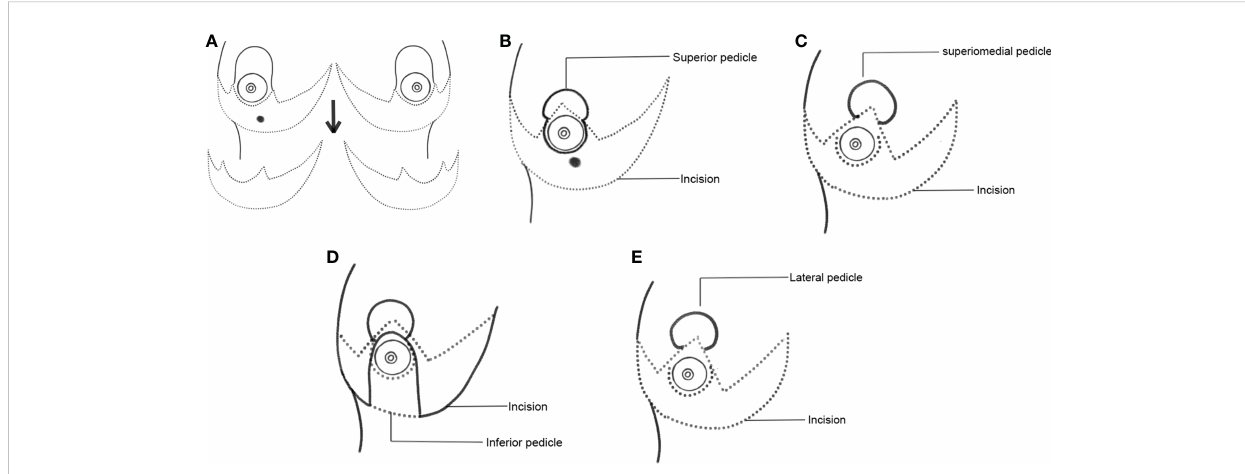
FIGURE 1 Schematic representation of Wise pattern incision and various choices of pedicles. (A) Wise pattern incision. (B) Superior pedicle. (C) Superior-medial pedicle. (D) Inferior pedicle. (E) Lateral